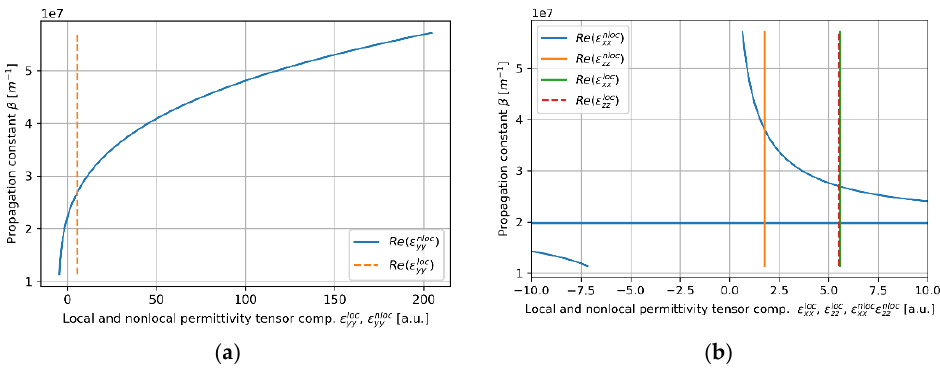
Figure 14. Real parts of components of effective local and nonlocal tensors (horizontal axis) of the core layer with dielectric layer thickness t Nb2O5 = 175nm plotted versus propagation constant (vertical axis), which are encountered by TE ( a ) and TM waveguide modes ( b